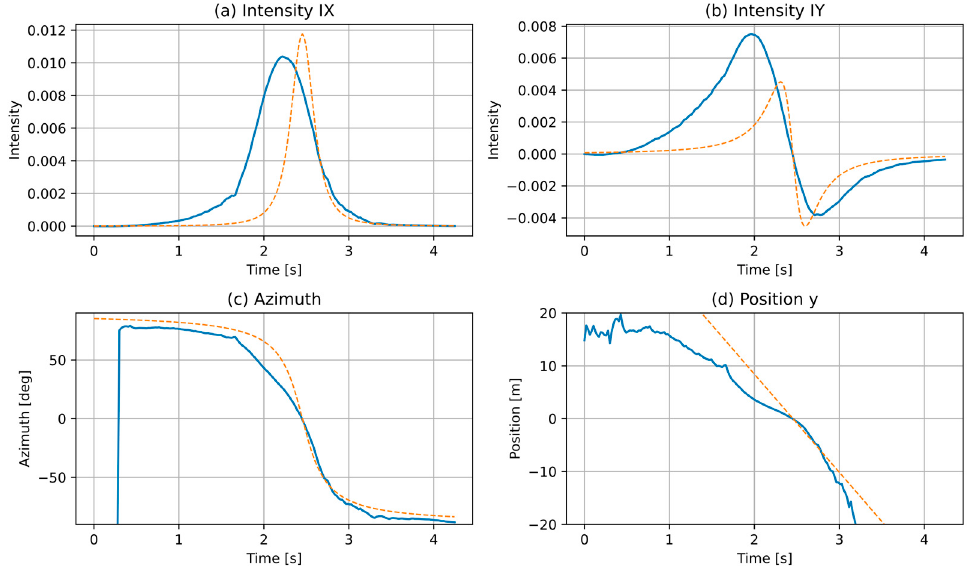
Figure 2. Comparison of signals recorded from a real road vehicle (solid line) with an ideal point source moving at the same speed (dashed line).